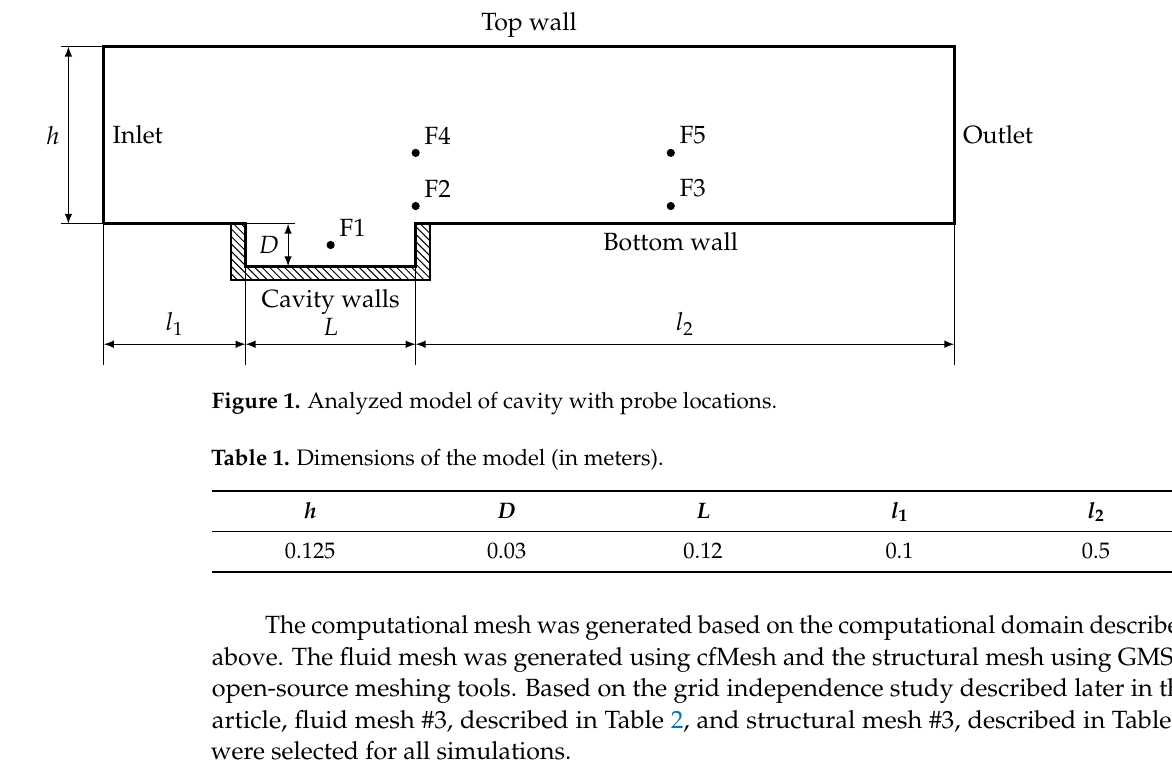
Table 2. Mesh parameters for finite volume grid independence study.